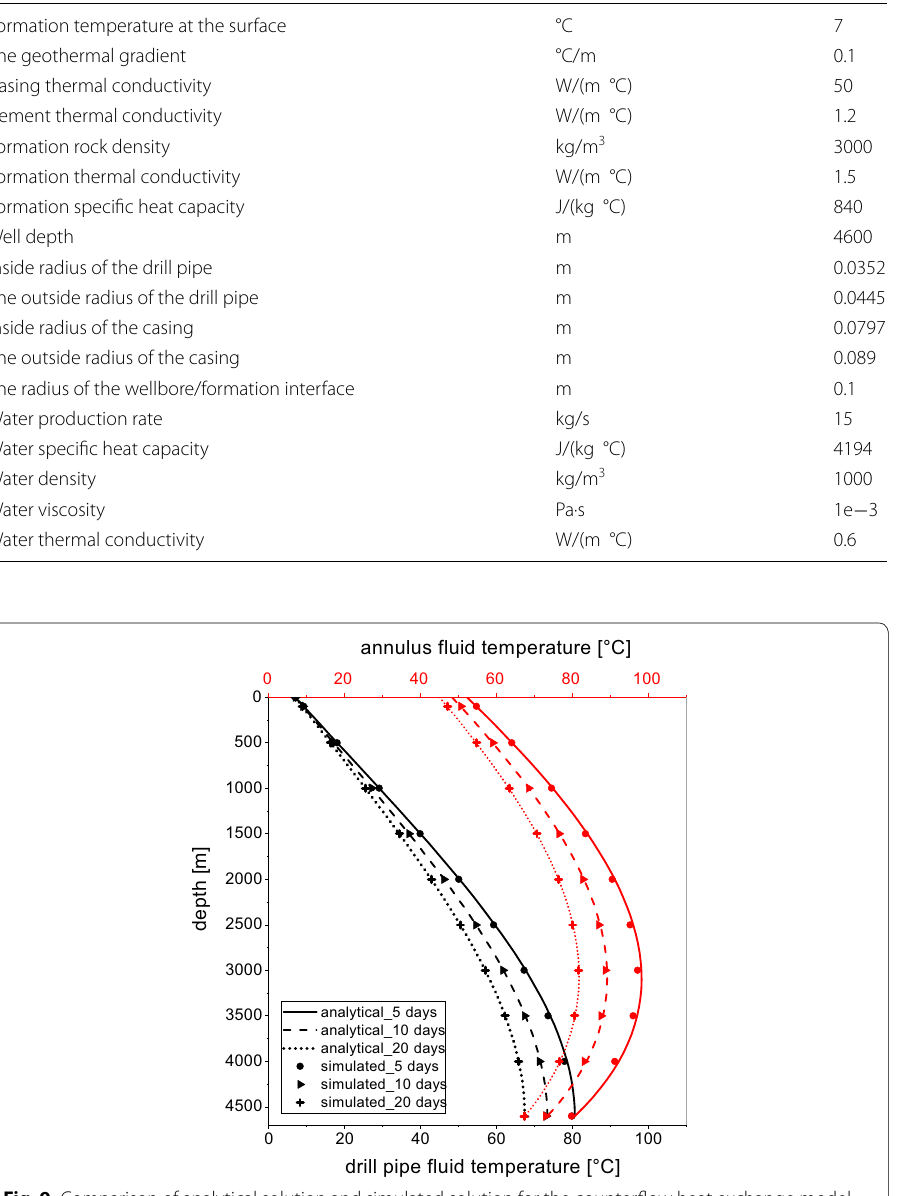
Fig. 9 Comparison of analytical solution and simulated solution for the counterflow heat exchange model. Black color represents the temperature of the fluid inside the drill pipe, red color represents the temperature of annulus fluid. Solutions were calculated and compared at three different circulation time: 5 days, 10 days, 20 days. The analytical solution was plotted in lines: solid lines (5 days), dash-dot lines (10 days), dot lines (20 days). The simulated solution was marked in symbols: circles (5 days), squares (10 days), crosses (20